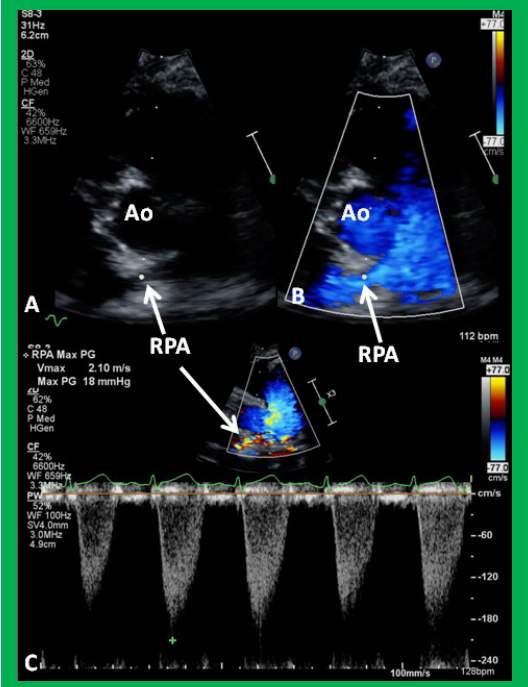
Figure 34. Selected video frames from parasternal short axis view demonstrating stenosis of the right pulmonary artery (RPA) by two dimensional ( A ) and color ( B ) and pulsed ( C ) Doppler imaging. Doppler calculated gradient was 18 mmHg ( C ). Ao, aorta.